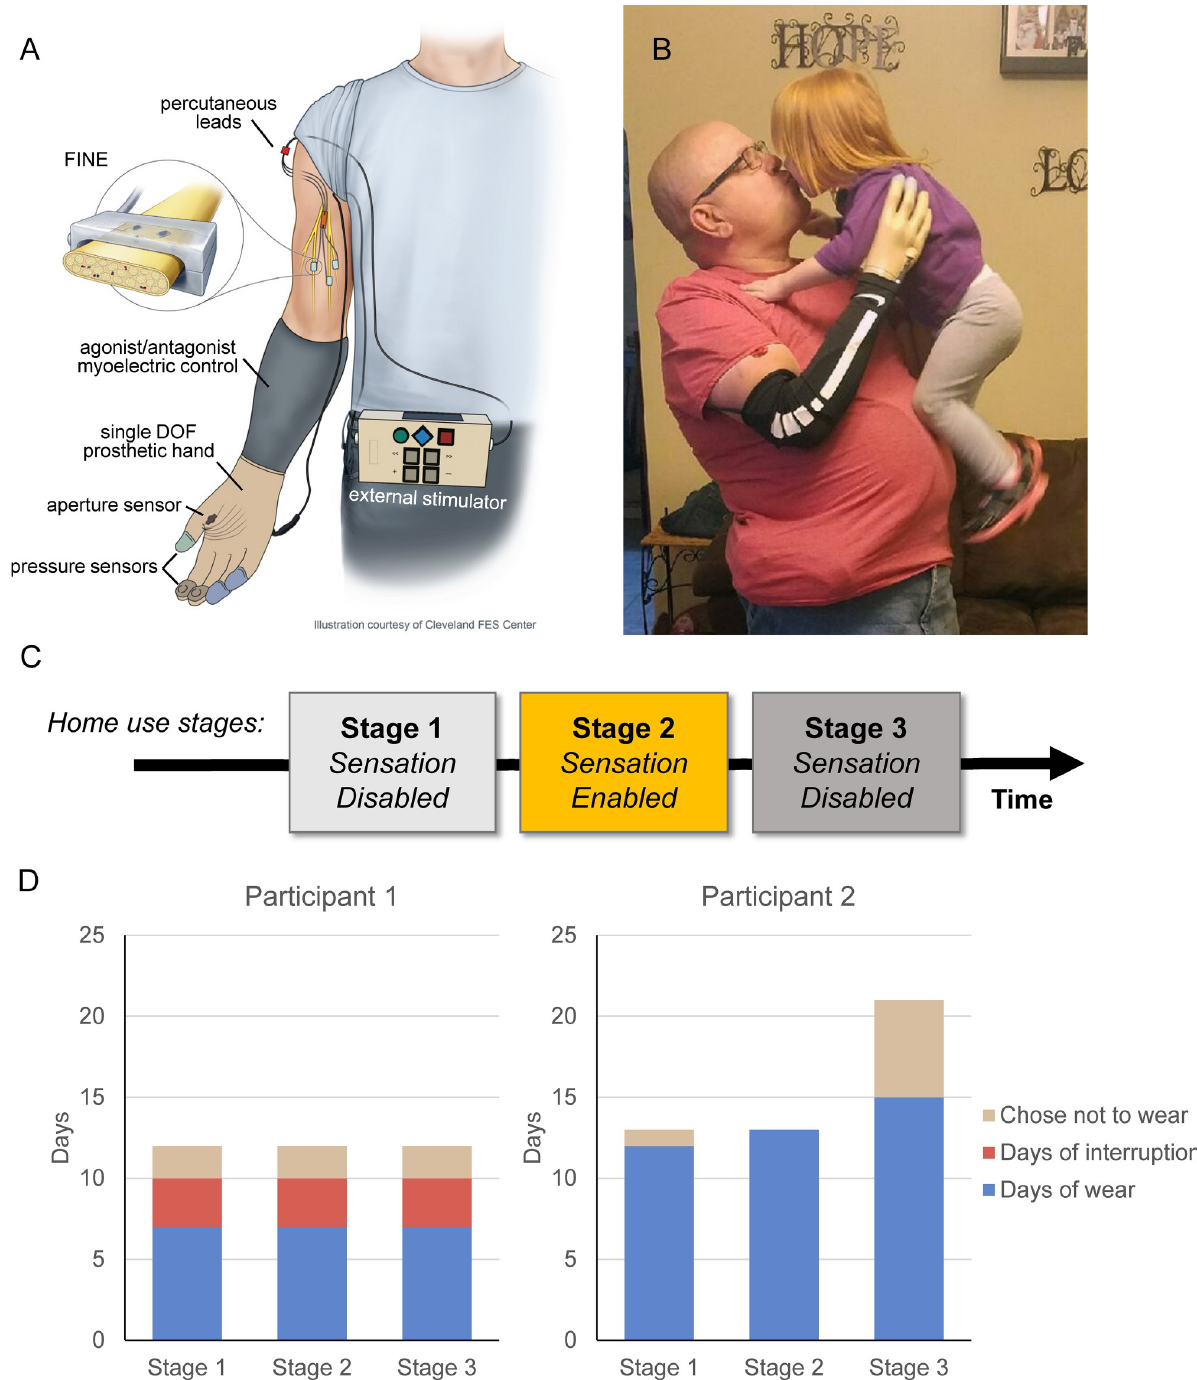
Fig 1. Take home sensory restoration system and study design. A) Schematic diagram of the take home system demonstrating system components and connections. B) A participant uses the sensory restoration system to embrace a child. C) Timeline of the study. Participants used the prosthesis system without sensory feedback in stages 1 and 3 and with sensory feedback enabled in stage 2. The participants came to the lab for testing sessions before the start of the study and after each stage. D) System wear-time per stage for participants 1 and 2.